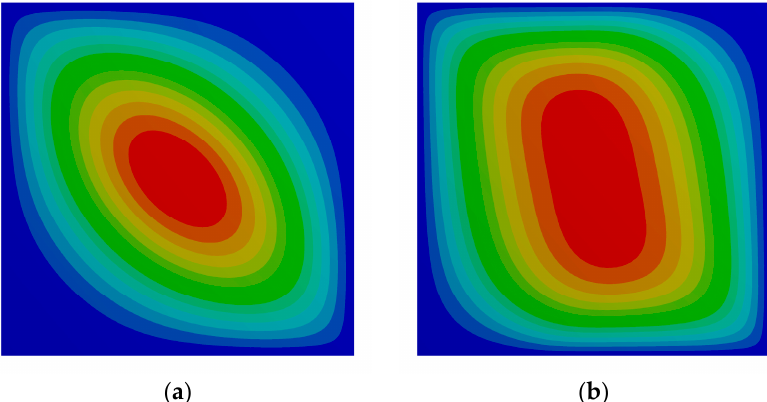
Figure 8. Critical buckling mode shape for the optimal layups for the SSSS plate. ( a ) CS and ( b ) VS biaxial buckling.